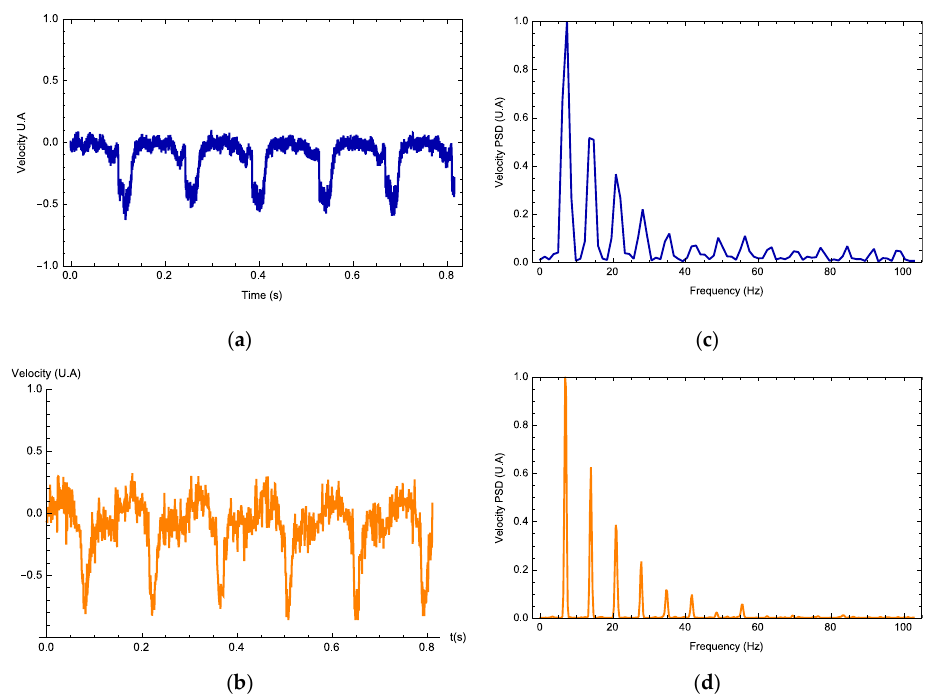
Figure 4. Photodyne movement velocity ( a , b ) and Fourier spectrum ( c , d ). Comparison of the theoretical (orange) and experimental results (blue). Rectangle signal, input frequency of 5 Hz. Calculated value of h = 41.4 and n ligth = 0.42.